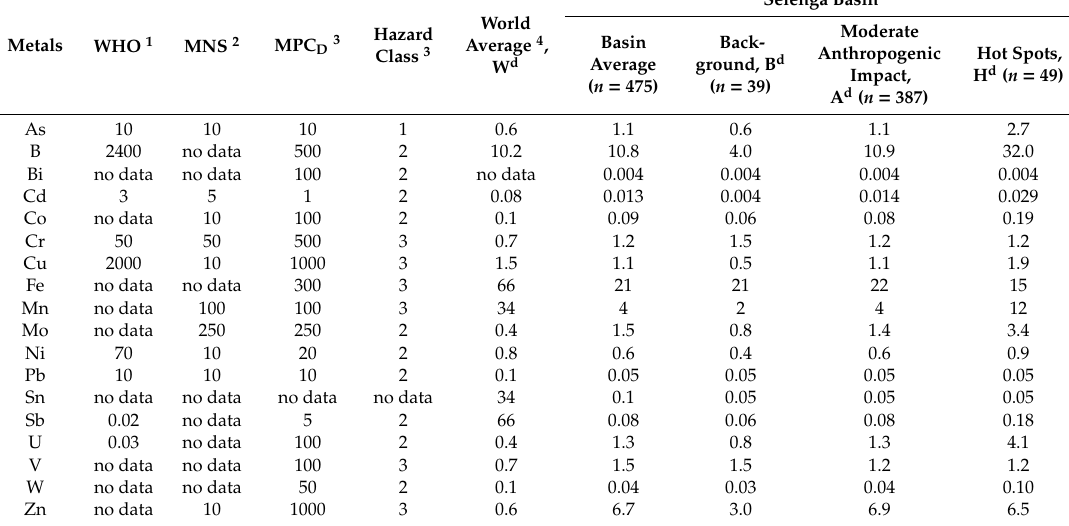
Table 2. WHO guidelines (WHO), Mongolian national standard (MNS), and Russian guidelines for drinking water (MPC D ) for dissolved metals and their content in river waters of the world and Selenga River basin ( µ g · L − 1 ): background and hot spots areas and areas with moderate anthropogenic impact (median